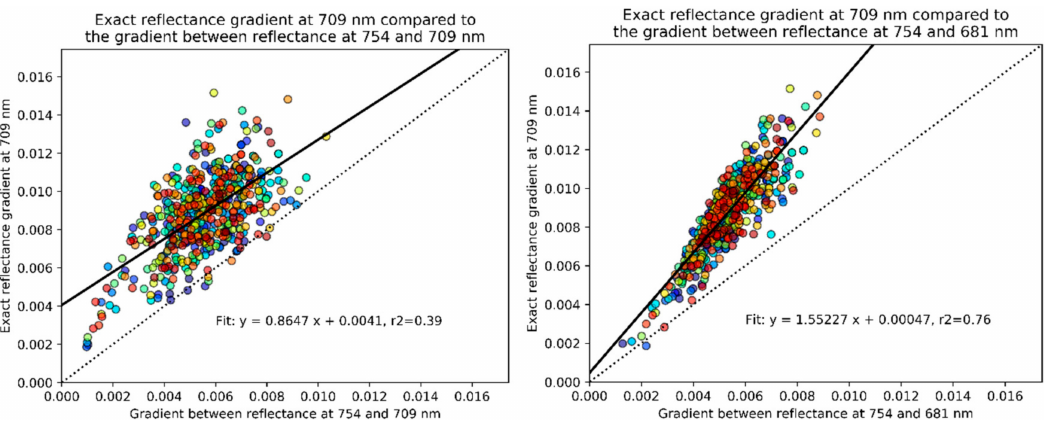
Figure 10. Relationships between exact red-edge reflectance gradient at 709 nm and its estimate from the ratio of the reflectance at two OLCI bands: 709 / 754 nm ( left ) and 681 / 754 nm ( right ). Datasets from the ECOSTRESS spectral library [28,29]. Linear regression presented along with coe ffi cient of